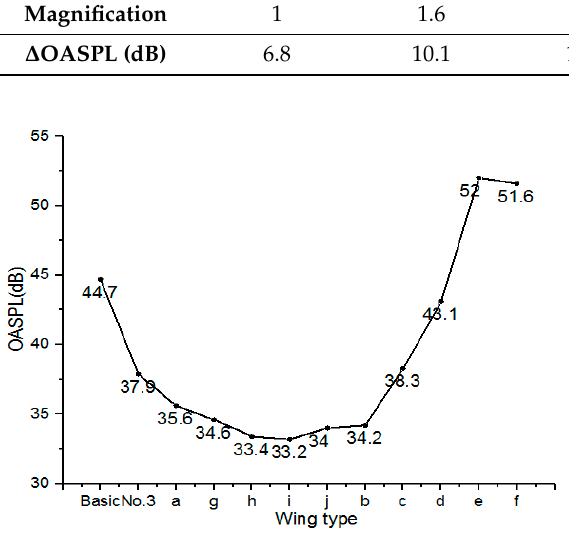
Table 6. Overall sound-pressure-level reduction for different bionic wings.